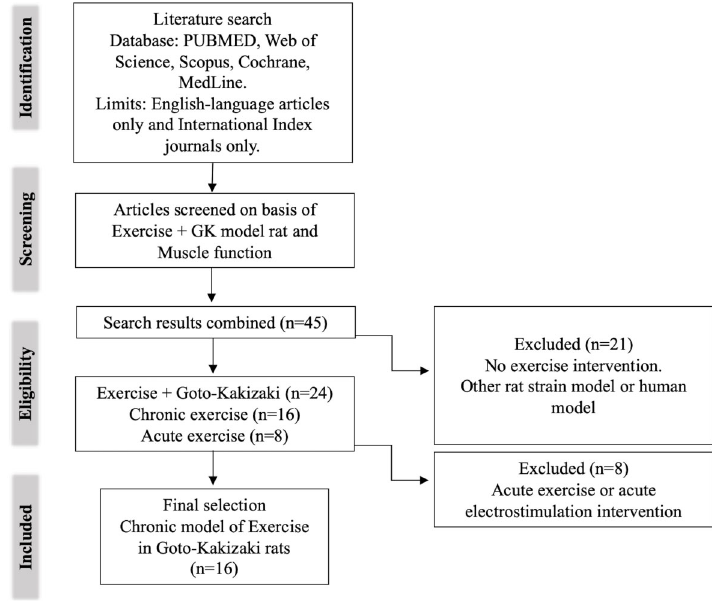
Figure 1. Flow chart of the study selection process for review preparation. GK: Goto-Kakizaki.